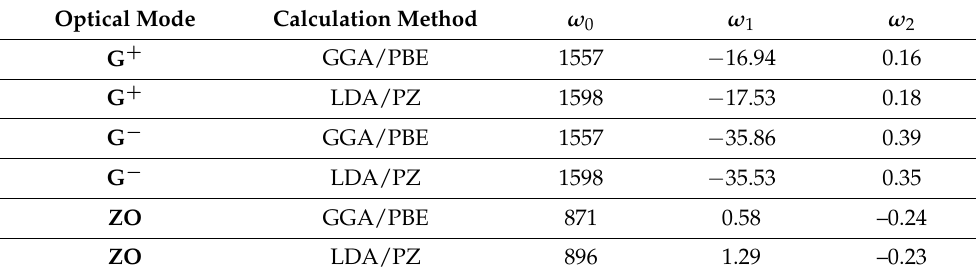
Table 5. Zero strain values ω 0 (in cm − 1 ), and coefficients ω 1 [in cm − 1 /(%strain)] and ω 2 [in cm − 1 /(%strain) 2 ] of the strain dependence [see Equation (3)] of the optical in-plane (G + and G − ) and out-of-plain ZO phonons at the Γ point, when the strain is applied along the armchair direction, as obtained by DFT